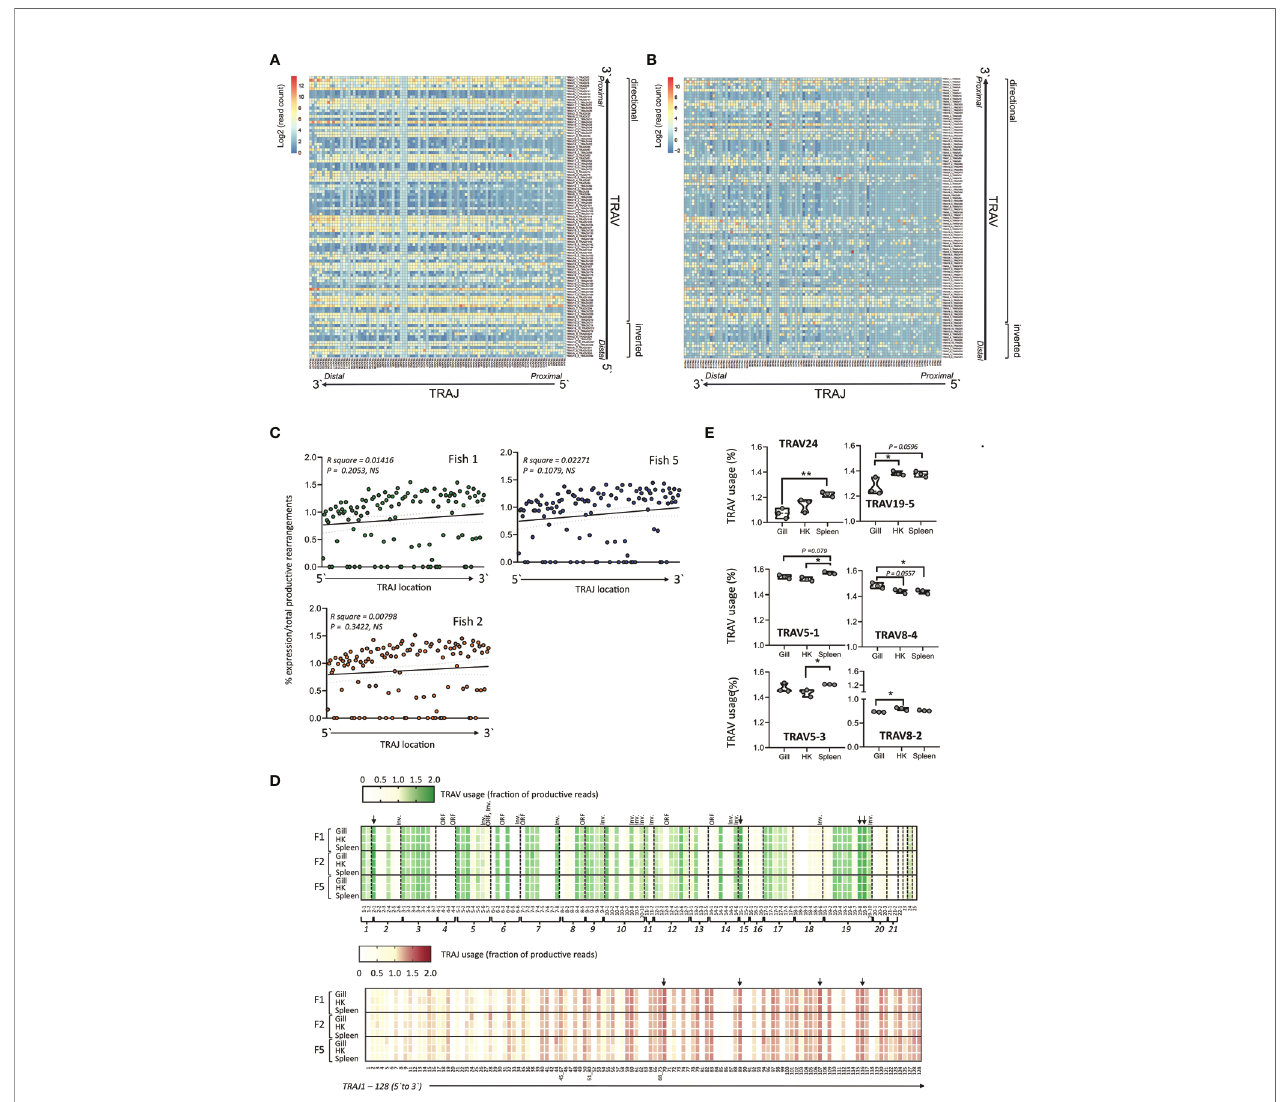
FIGURE 7 | Heat map of representative productive (A) or unproductive (B) TRAV- J combinations in Atlantic salmon. The average expression of TRAV-J combinations was computed from the TRA repertoire of the total number of productive sequences from gill, head kidney and spleen from three individual presmolt Atlantic salmon. The expression of each combination was expressed as total reads and the resulting matrix was normalized and represented as a heat map with a log2 count scale. TRAJ and TRAV genes are displayed as each gene appear in the genome following a 5`to 3`direction and the transcriptional direction of the TRAV genes is indicated. (C) Scatterplot of the relative expression of TRAJ genes versus genome location showing no signi fi cant correlation. The most 5` TRAJ corresponds to TRAJ1 and is located closest to the TRAC gene. The average of normalized expression frequencies in gill, HK and from three fi sh is shown. (D) TRAV and TRAJ usage in Atlantic salmon. TRAV and TRAJ usage was determined from deep sequencing datasets of C alpha (TRAC) primed 5`-RACE generated from gill, head kidney (HK) and spleen of three unvaccinated pre-smolt Atlantic salmon. TRAV and TRAJ usage in each individual and tissue was expressed as the percentage of total productive TRA rearrangements from normalized data sets. Inv. = inverted orientation of TRAV genes, ORF = open reading frame genes (TRAV4-2, TRAV4-4, TRAV5-7, TRAV6-3, TRAV7-1, TRAV12-3 and TRAV14-1), Downward pointing arrows indicating the four most frequently used TRAV (TRAV2-1, TRAV15-1, TRAV19-8 and TRAV19-9) and TRAJ genes (TRAJ70, TRAJ89, TRAJ107 and TRAJ116) common to all three fi sh. (E) Tissue preferential TRAV usage. The relative expression of speci fi c TRAV genes in gill, Head kidney (HK) and spleen from three pre-smolt Atlantic Salmon were determined by comparing the normalized percentage of total productive TRAV rearrangements in each tissue among the three individuals, statistical signi fi cance was determined by one way ANOVA followed by Tukey ’ s multiple comparisons test with *p<0.05 and